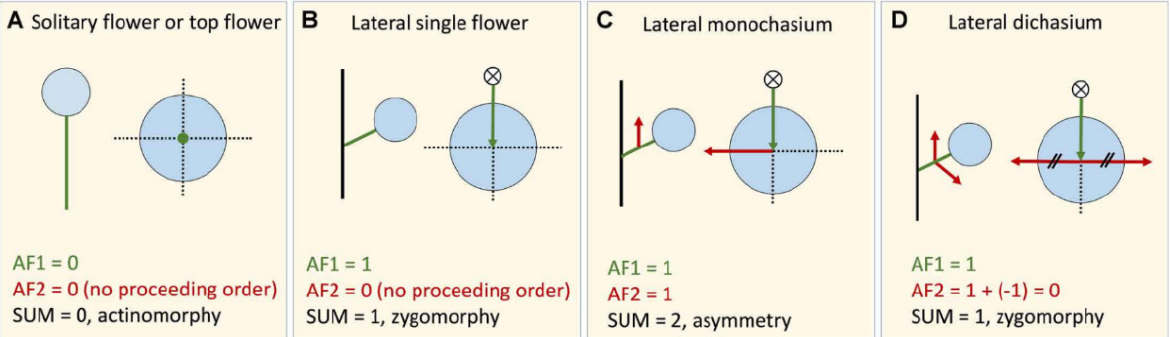
Figure 13. Explanatory model for the floral symmetry influenced by the inflorescence structure. ( A ) Solitary flower or top flower, AF1 = 0, no preceding order or AF2 = 0, the sum of two asymmetry factors is 0, usually the floral symmetry is actinomorphy. ( B ) Lateral single flower, AF1 is 1, and no proceeding order/flower, AF2=0, the sum of two asymmetry factors is 1, the flower tends to be zygomorphic. ( C ) Lateral monochasium, AF1 is 1, AF2 is 1, the flower has two asymmetry factors with different directions. SUM AF is 2. This explains the floral asymmetry in Cannaceae. ( D ) Lateral dichasium, AF1 is 1, as it produced two branches/flowers in opposite directions, the asymmetry factors of proceeding order offset each other, AF2 is 0. The flower has SUM AF = 1 along dorsal-ventral direction and theoretically is dorsal-ventrally zygomorphic. AF1, asymmetry factor produced by the preceding order, indicated by green arrow; AF2, asymmetry factor produced by the proceeding (next) order, indicated by red arrow.